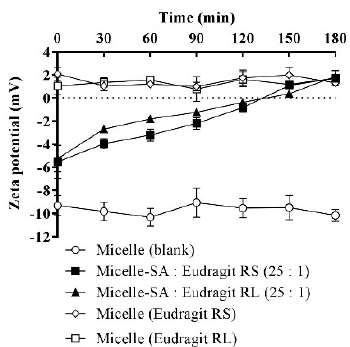
Figure 7. Time-dependent zeta-potential changes of micellar droplets containing SA-polymer com- plexes featuring a SA-to-polymer ratio of 25:1 with Eudragit RS/RL after 1:100 dilution in 10 mM phosphate buffer (pH 6.8), at 30 min time intervals for 180 min at 37 °C. Zeta-potential values of the blank micelle and micelles containing the same polymer amount used in micellar complexes without SA were also assessed after 1:100 dilution in the buffer. Indicated values are the means ± SD ( n ≥ 3).